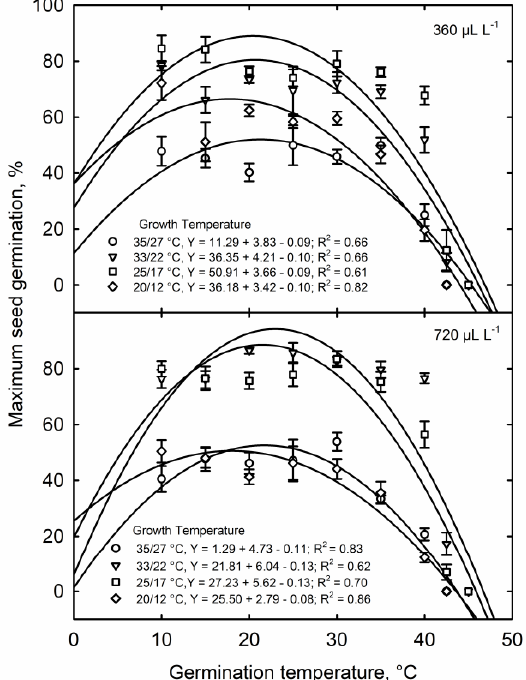
Figure 3. Effect of germination temperatures on the maximum seed germination of eight parental environments described by quadratic functions. Data are means ± standard error (SE) of four plants ( n = 4) harvested from a given SPAR unit and used as replicates in statistical analysis for a respective parental environment.